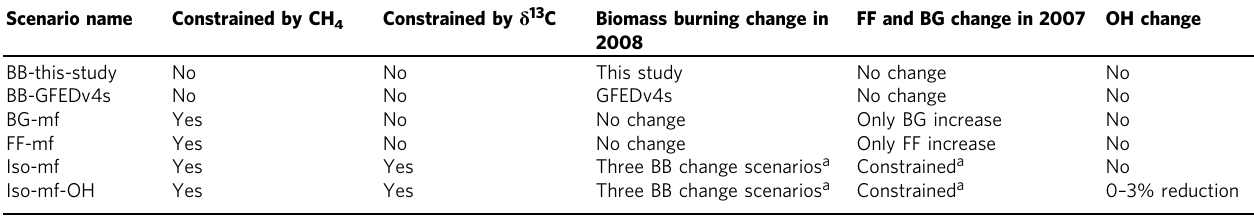
Table 2 Description of CH 4 box-model scenarios Scenario name